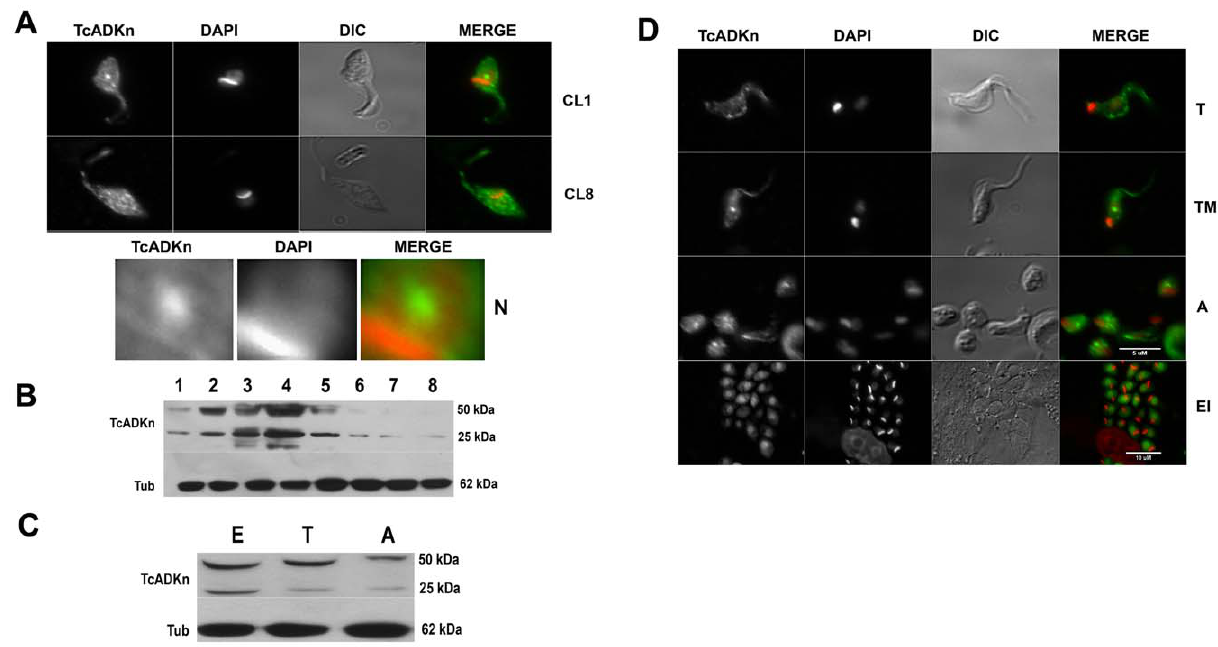
Figure 1. Tc ADKn expression in the different stages of T.cruzi . A) TcADKn localization in epimastigotes of T. cruzi along the growth curve. Parasites were grown BHT medium, starting from 1 6 10 6 epimastigotes, samples were collected at day 1 of culture (CL1) and day 8 (stationary phase, CL8). TcADKn localization was followed by indirect immunofluorescence using specific anti-TcADKn mouse generated antibodies. Nuclear are was enlarged for nucleolar visualization (N). B) Western Blot analysis using anti-TcADKn antibodies, to study its expression along the epimastigotes growth curve. T. cruzi epimastigotes were grown in BHT medium, starting from 1 6 10 6 total parasites; samples were collected daily for protein sample preparation. In each lane 4 6 10 6 parasites were loaded. C) Western Blot analysis in the three main stages of T. cruzi life cycle epimastigotes, trypomastigotes and amastigotes. In every Western Blot, tubulin (TUB) was used as loading control. In each lane 4 6 10 6 parasites were loaded. D) Indirect immunofluorescence to study TcADKn localization in mature trypomastigotes (T), metacyclic trypomastigotes (TM), amastigotes (A), intracellular epimastigotes (EI). Infective stages were obtained from infection of VERO cells, trypomastigotes (T) were collected daily 5 days post- infection, and amastigotes (A) were collected 10 days post-infection. Intracellular epimastigotes (EI) were obtained 7 days